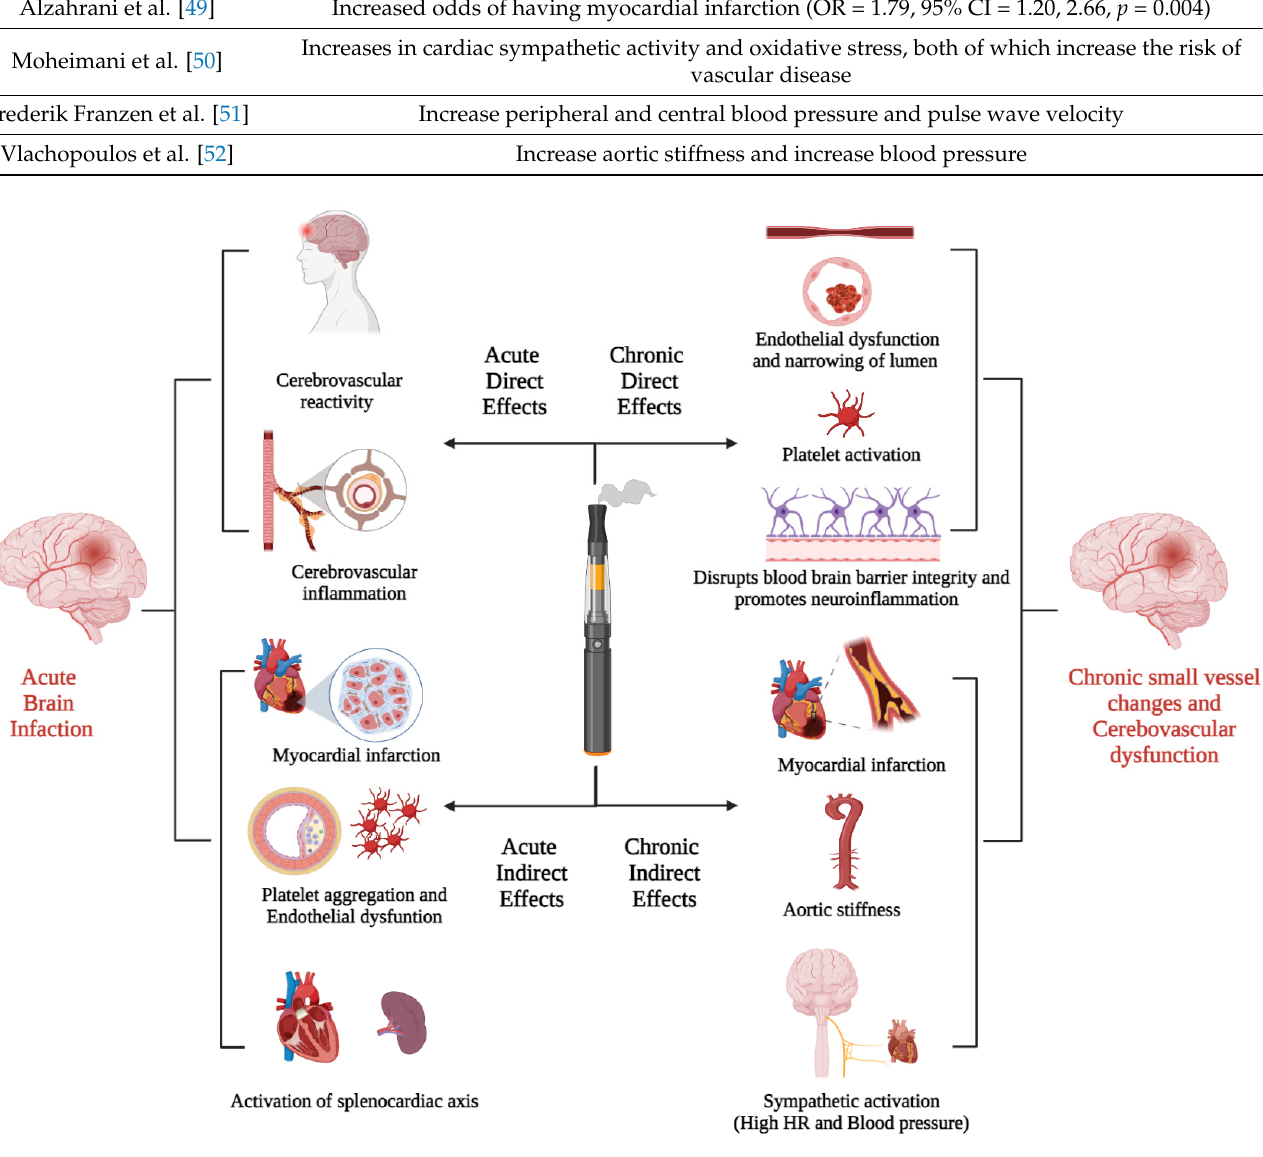
Figure 1. Acute and chronic effects of e-cigarettes smoking on cerebrovascular and cardiovascular systems Table 5. Acute and chronic effects of e-cigarettes as a possible risk factor and trigger for stroke.